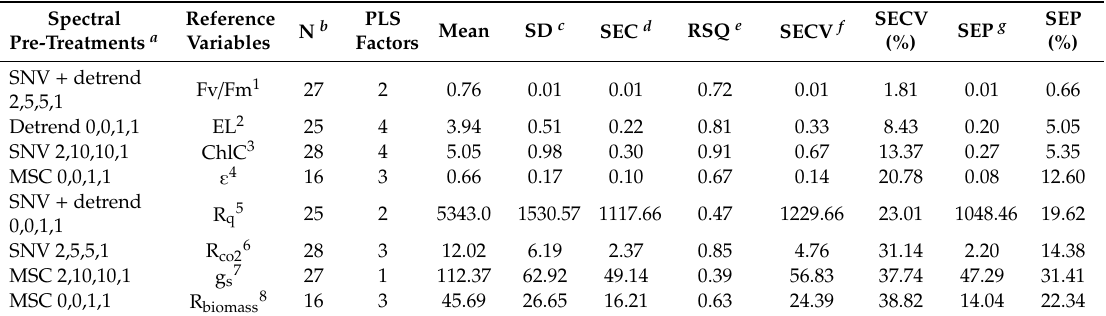
Table 5. Main statistical descriptors for the modified partial least squares (PLS) models developed in the near infrared reflectance zone close to 1100–2300 nm.